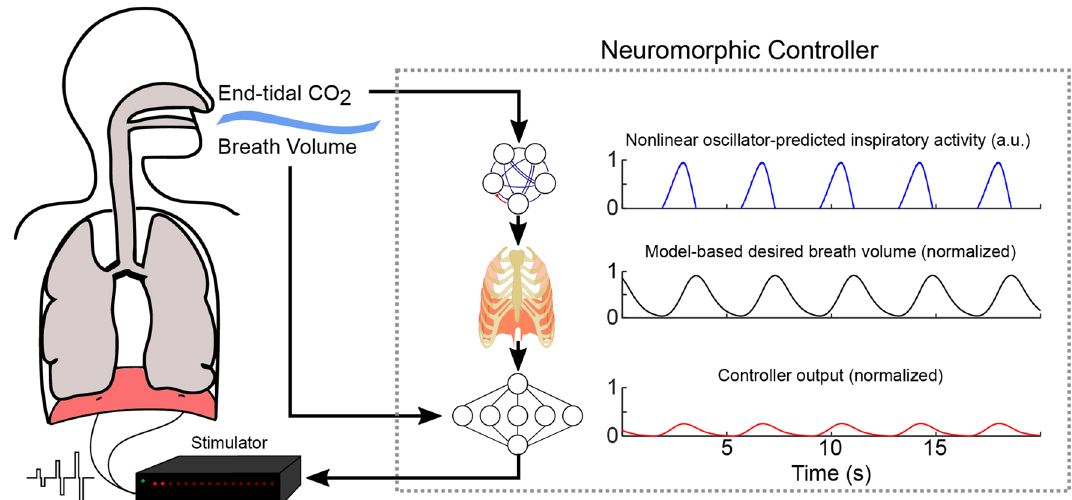
Figure 1. General concept for the adaptive neuromorphic closed-loop control system for respiratory pacing. The adaptive controller uses measurements of end-tidal CO 2 to predict, through a model-based approach,